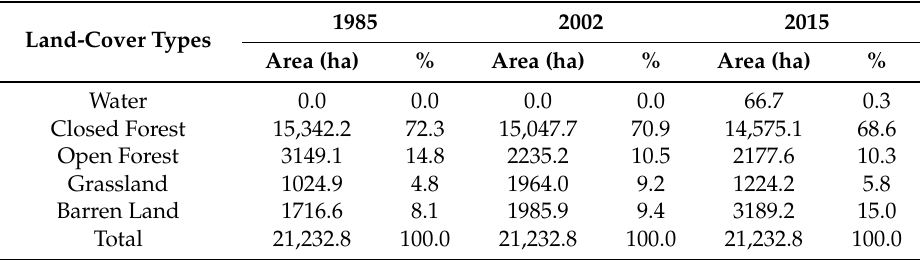
Table 3. Summary of the area and percentage of land-cover